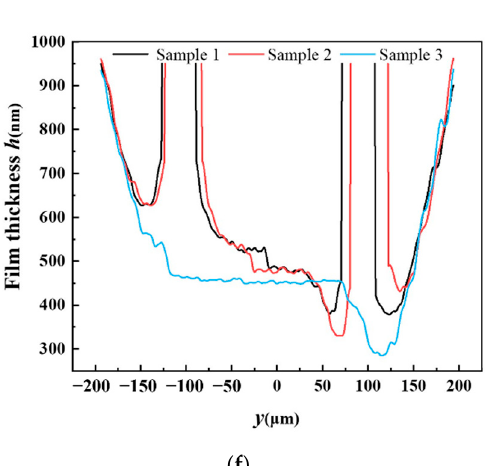
Figure 10. Film thickness profile of sample 1 and sample 2 with textures located at the entrance of contact region: ( a ) distribution of film thickness—32 mm/s; ( b ) film thickness profile along direction—32 mm/s; ( c ) distribution of film thickness—256 mm/s; ( d ) film thickness profile along the y direction—256 mm/s; ( e ) distribution of film thickness—512 mm/s; and ( f ) film thickness profile along the y direction—512 mm/s.